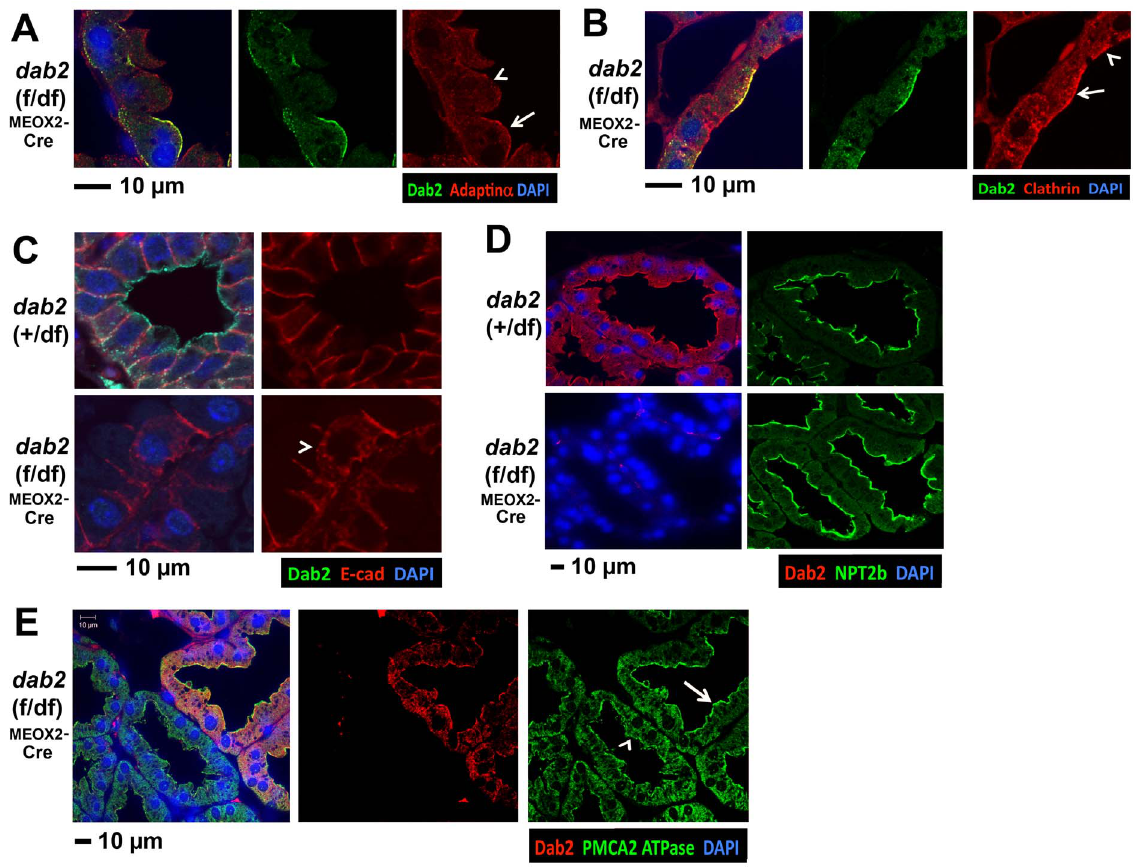
Figure 4. Mild effects of Dab2 deletion on endocytic components and polarity markers in mammary epithelia. Mammary glands from lactating (5 days) mice of dab2 heterozygous controls and mosaic knockouts ( dab2 (f/df):Meox2-Cre) were analyzed by confocal immunofluorescence microscopy for several endocytosis and polarity markers. Where possible, markers were compared between Dab2-positive and Dab2-negative cells in the same section of the mosaic dab2 -deleted tissues. ( A ) Adaptin alpha and Dab2 double staining of mammary glands from a mosaic dab2 -deleted mouse, comparing Dab2-positive (arrow) and negative (arrowhead) cells; ( B ) Clathrin and Dab2 co-staining of mammary glands from a mosaic dab2 - deleted mouse, comparing Dab2-positive (arrow) and negative (arrowhead) cells; ( C ) Dab2 and E-cadherin staining: E-cadherin is localized more in the cytoplasm in Dab2-deleted cells (arrowhead); ( D ) NPT2b, a sodium-phosphate cotransporter; and ( E ) PMCA2 ATPase, a calcium pump, in Dab2- positive (arrow) and negative (arrowhead) cells. The results are the representation of multiple slides from 3 control (wildtype and heterozygous) and 3 dab2 conditional knockout mice.